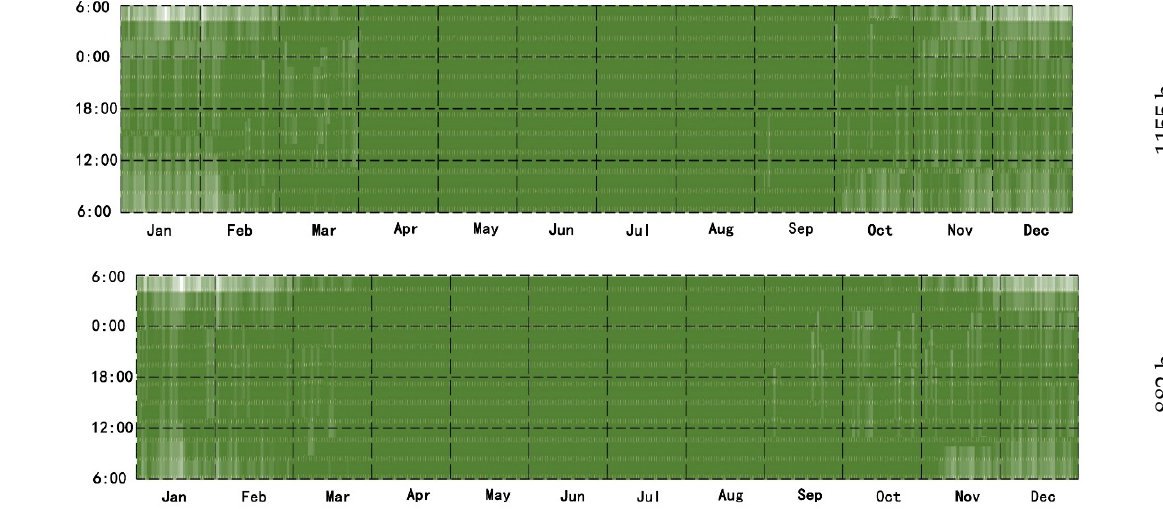
Figure 15. ( a ) Firewall–Sunlight system (with WSR). ( b ) Firewall-–Sunlight system (without WSR).